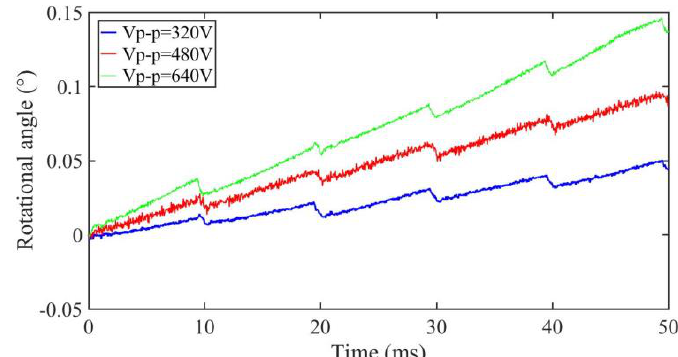
Figure 8. Stepping characteristics of the prototype motor under different driving voltages.